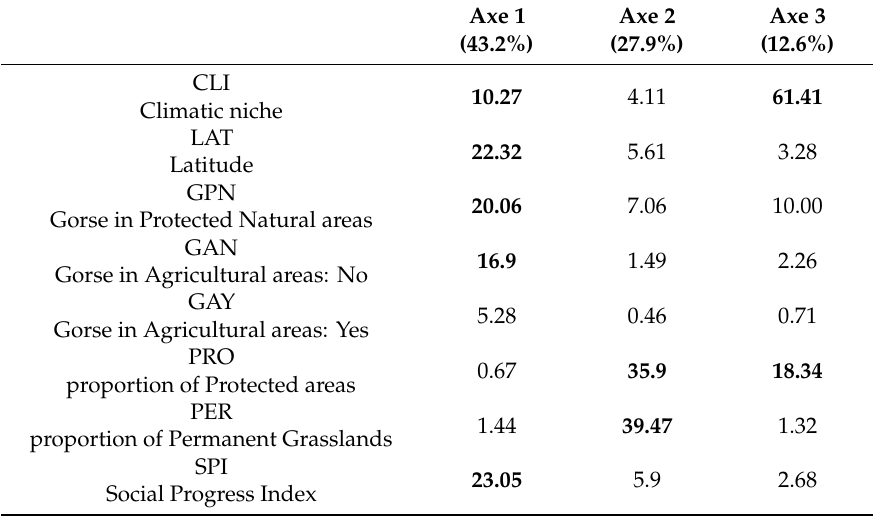
Table 4. Absolute contribution of the first three axis and relative contribution (%) of each variable to these axis. In bold, contribution >